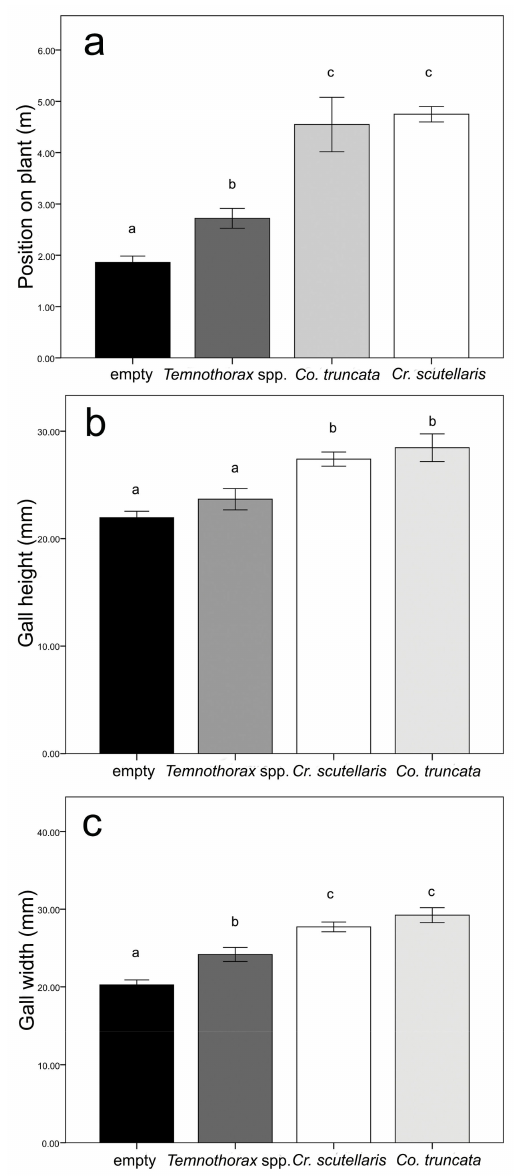
Figure 2. Graphs showing gall preferences of the di ff erent ant species according to the data collected in the field survey. The gall preferences are measured as gall position on plant ( a ), gall height ( b ), and gall width ( c ). The SE interval is shown for each bar. The bars with the same letter are not statistically di ff erent (One-way ANOVA, see text for further